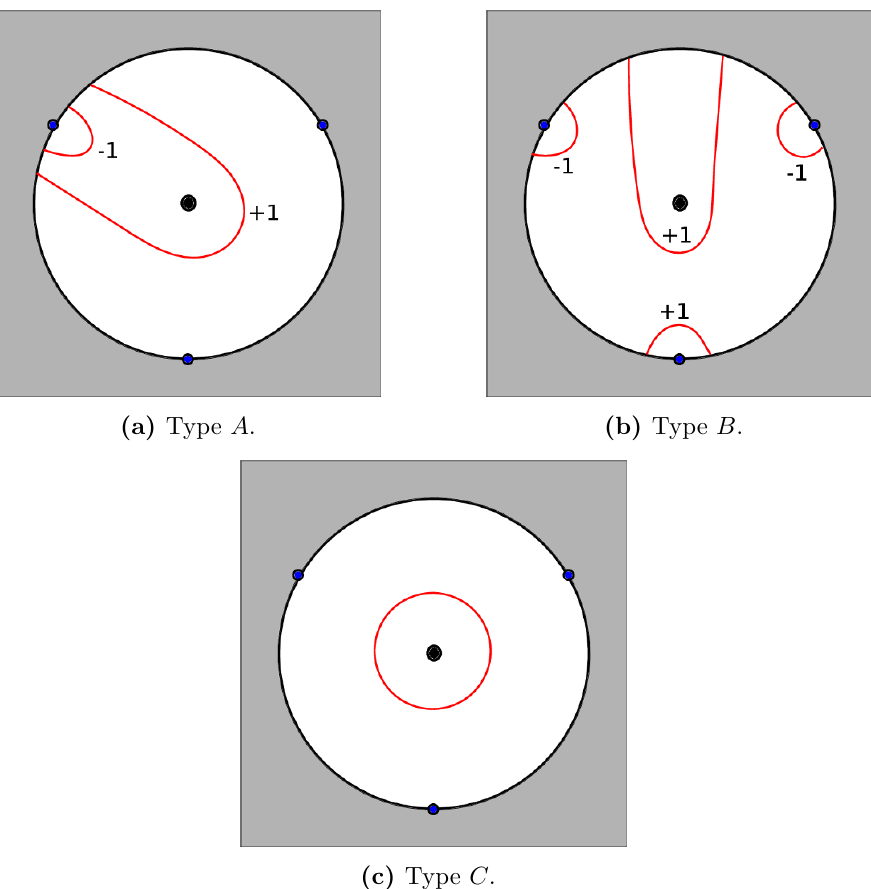
Figure 15. Three types of laminations in ( A 1 ; D 3 ) Argyres-Douglas